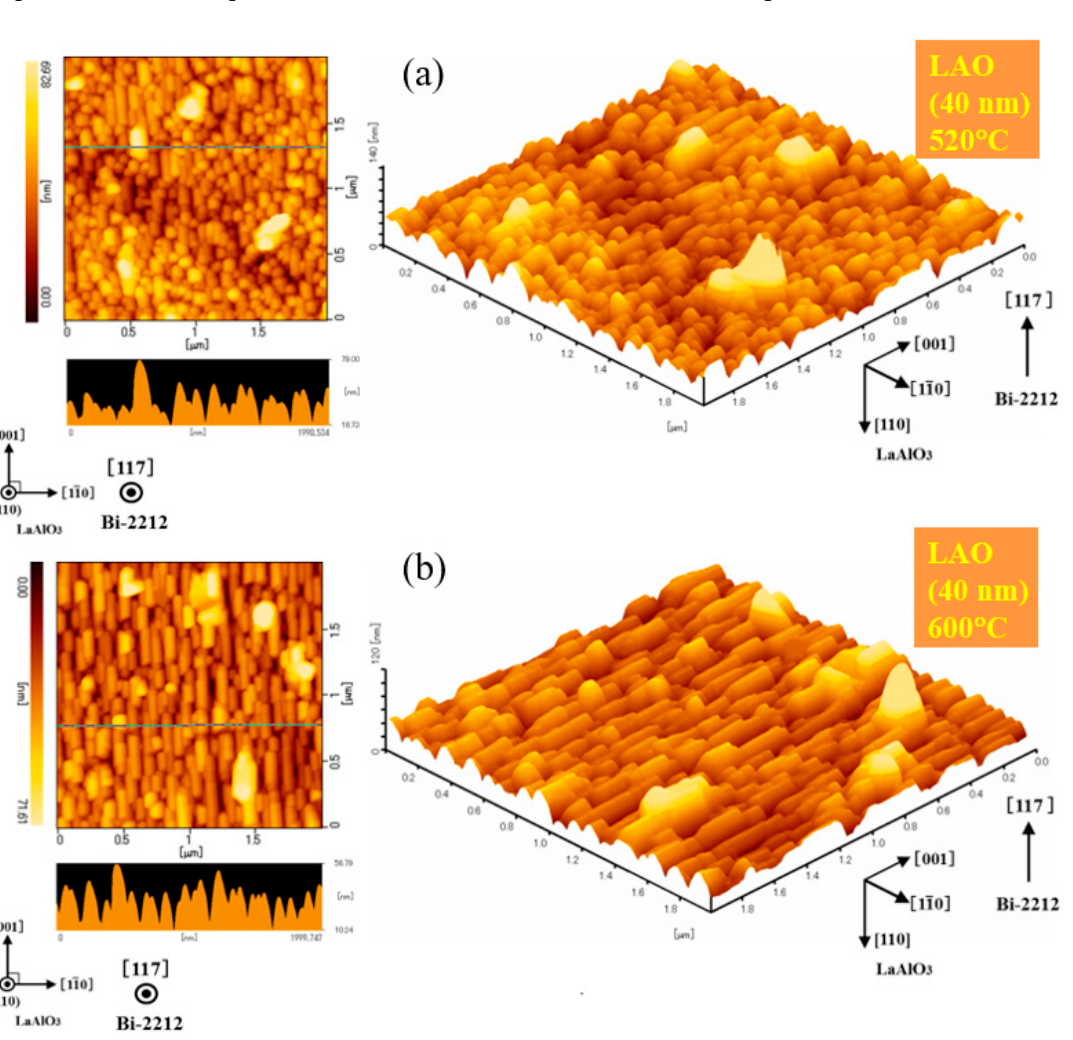
Figure 4. AFM 2D and 3D images and roughness profile for the non c -axis Bi-2212 thin film on flat (110) substrate grown at ( a ) 520, RMS = 9 nm and ( b ) 600 ◦ C, RMS = 12.06 nm.